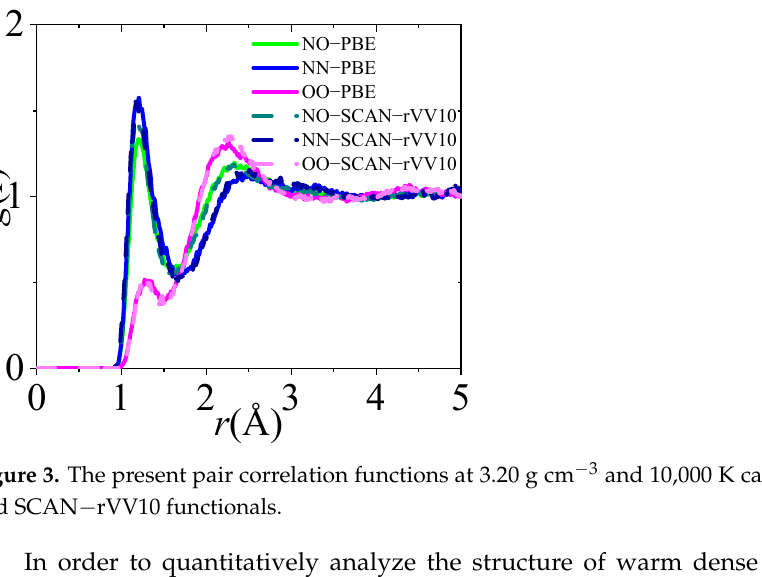
Figure 2. Pair correlation functions g(r) for warm dense NO calculated by PBE functional at different densities and temperatures, compared with that of Zhang et al. [24] ( a – d ) and Mazevet et al. [26] ( e , f ).